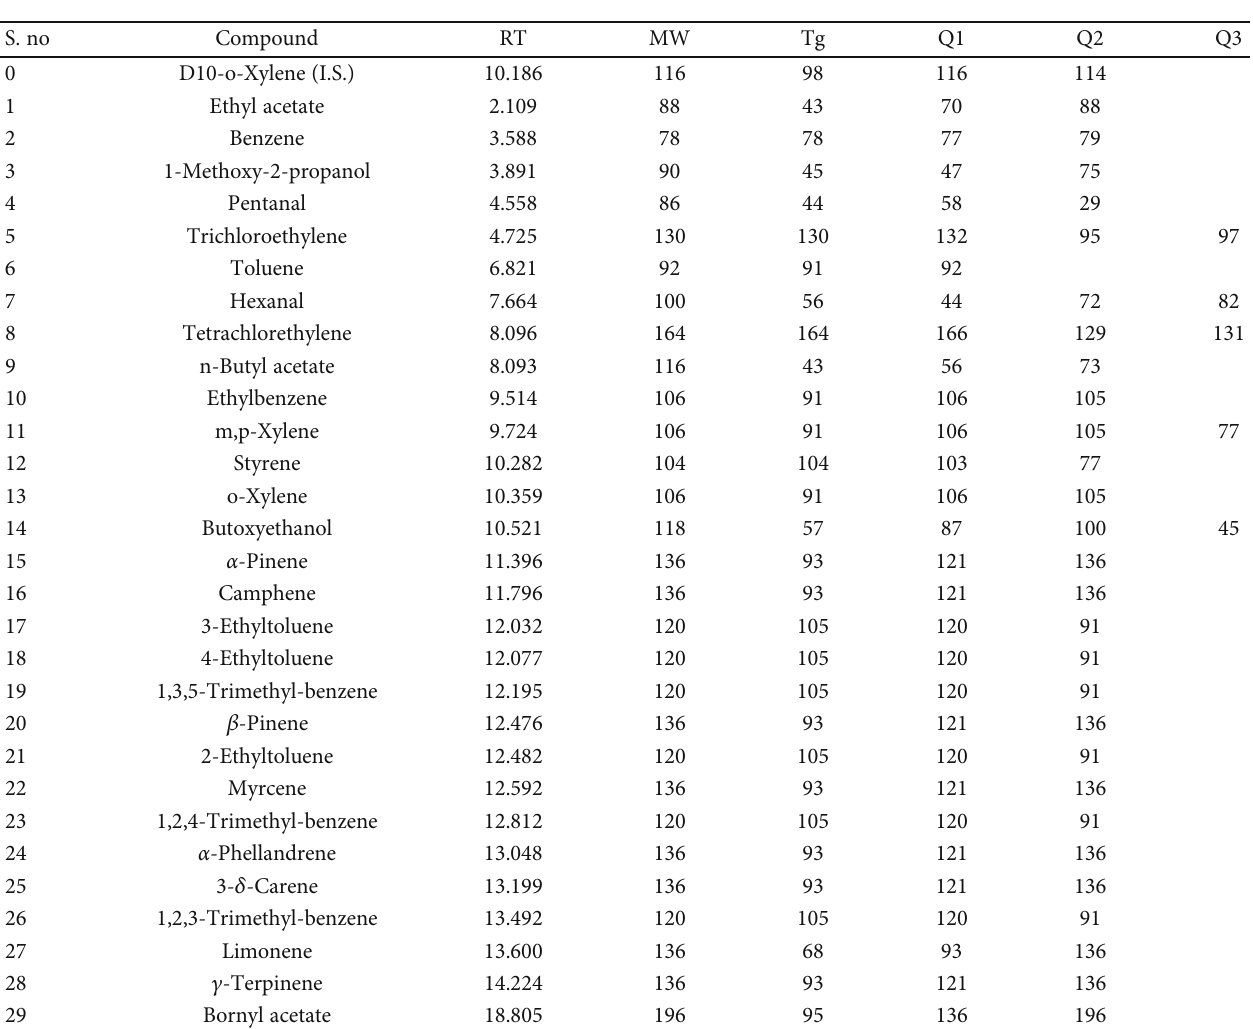
Table 2: List of di ff erent VOCs with their characteristic